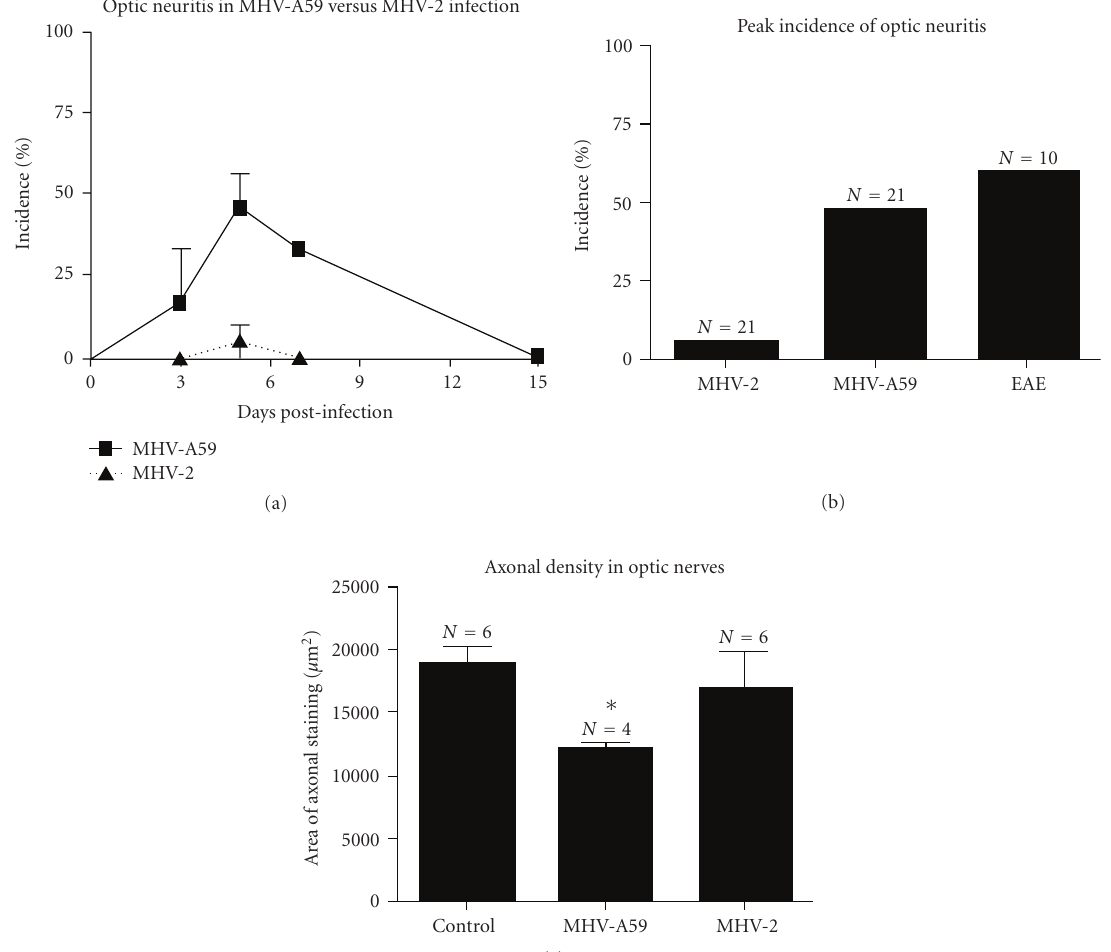
Figure 8: Occurrences of ON and axonal loss in MHV-infected and EAE mice. (a) ON, determined by presence of any level of inflammation in the optic nerve, is detected as early as day 3 post inoculation with MHV-A59. Incidence increases by day 5, persists at day 7, and resolves by day 15. In contrast, almost no MHV-2-infected mice develop ON over the same time course. Mean ± SEM incidence from 3 experiments is shown. (b) The peak incidence of MHV-A59-induced ON, detected at day 5 postinoculation, was 48% (10 of 21 nerves) whereas only one of 21 nerves from MHV-2-infected mice developed ON. 60% (6 of 10) of optic nerves from EAE (experimental autoimmune encephalitis; autoimmune model for demyelination) mice develop ON at the peak of inflammation on day 11 post immunization. (c) The area of axonal staining (mean ± SEM) detected by Bielschowsky silver impregnation is significantly lower in optic nerves from MHV-A59-infected mice as compared to optic nerves from control, uninfected mice or MHV-2-infected mice ( ∗ P ≤ . 05). (adapted from the work of